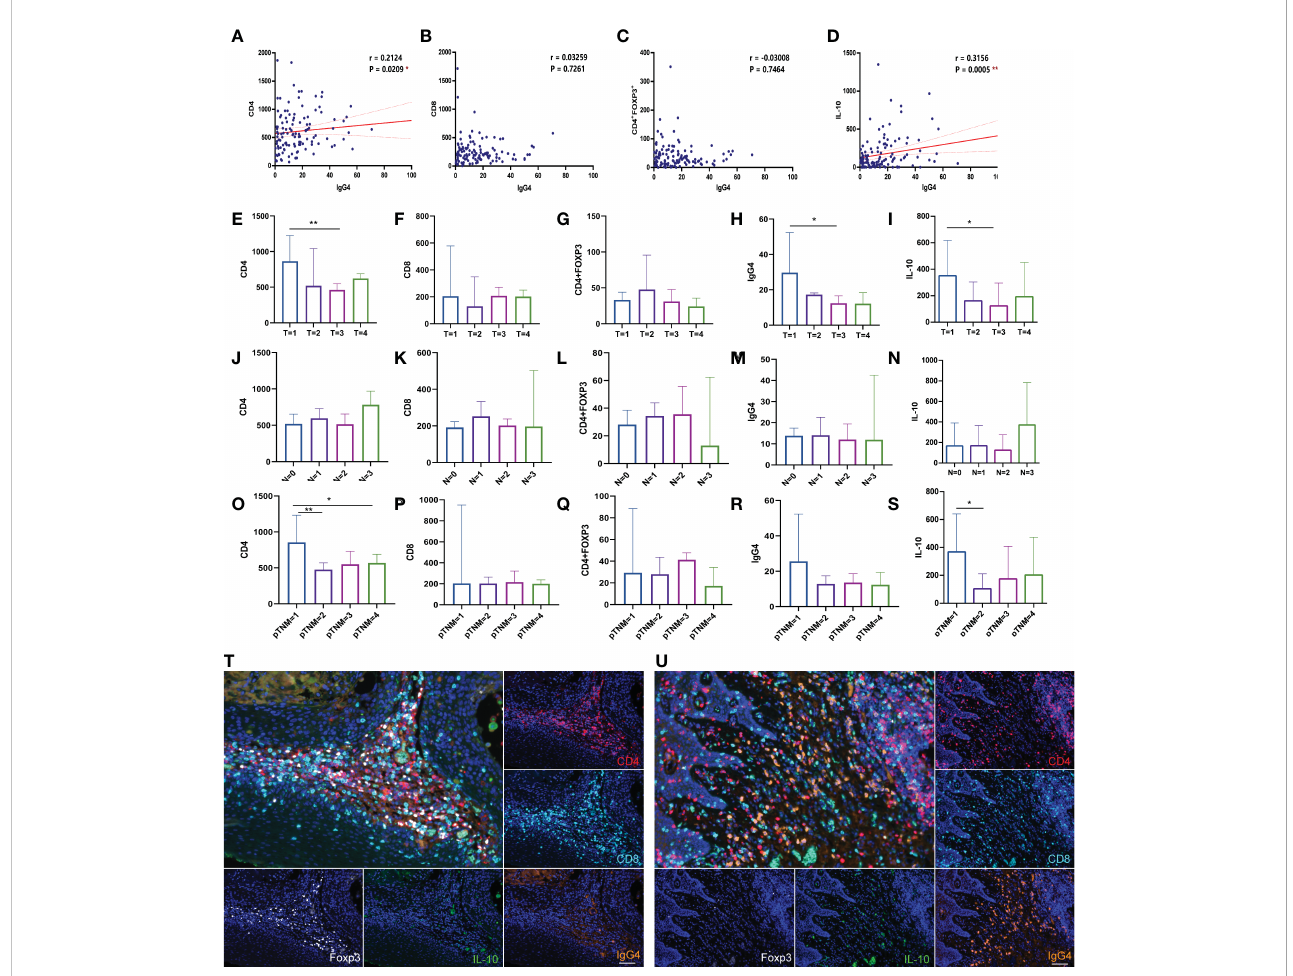
FIGURE 2 (A – D) Correlation analysis of IgG4, with CD4, CD8, Foxp3 and IL-10 positive cells (n=118). (E – S) Comparison of CD4, CD8, Treg, IgG4 and IL-10 in different T stages, N stages, pTNM stages (n=118). (T, U) The two fi gures show the typical multicolor immuno fl uorescence staining image located at high Foxp3 or IgG4 positive cells expressing area. Scale bar=60 m m. *p<0.05,